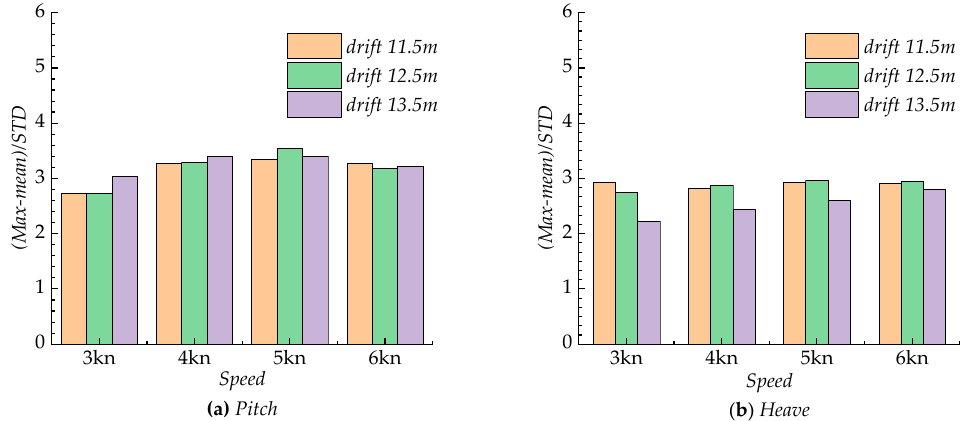
Figure 10. Normalized maximums for different drift depths and towing speeds.